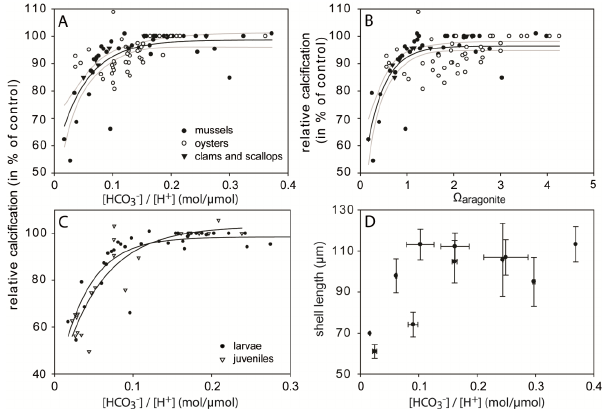
Figure 4. Meta-analysis of the relative calcification response (as % of control): bivalve larvae during the lecithotrophic phase plot- ted against seawater [HCO − ] / [H + ] (a) and (cid:127) (b) . Comparison of 3 Mytilus spec. larvae and juveniles plotted against calculated seawa- ter [HCO − ] / [H + ] (c) . Exp. 4 Shell length of M. edulis larvae 70 3 hpf plotted against seawater [HCO − ] / [H + ] (d) . Relative calcifica- 3 tion rates were calculated from either shell length (larvae) or shell mass growth (juveniles).